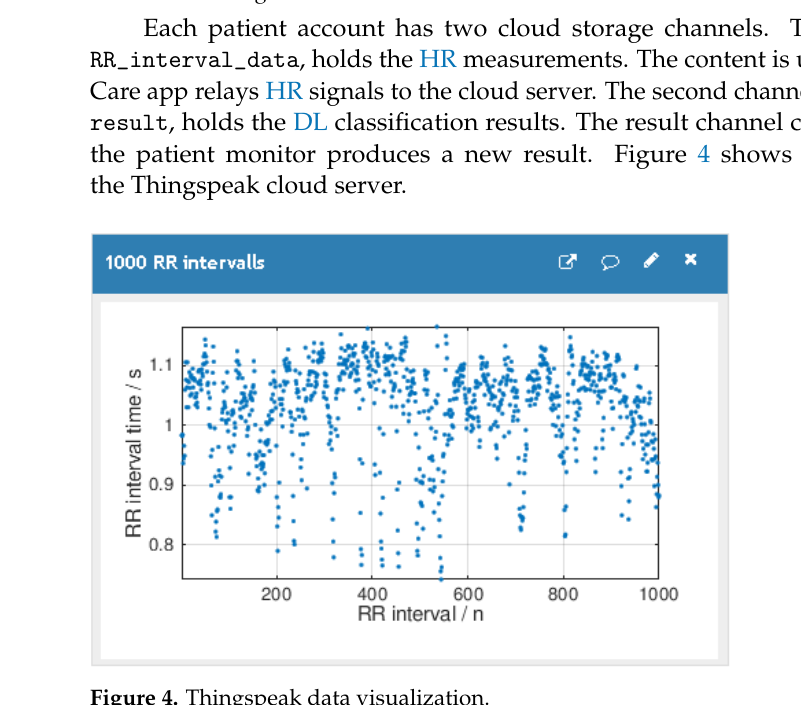
Figure 4. Thingspeak data